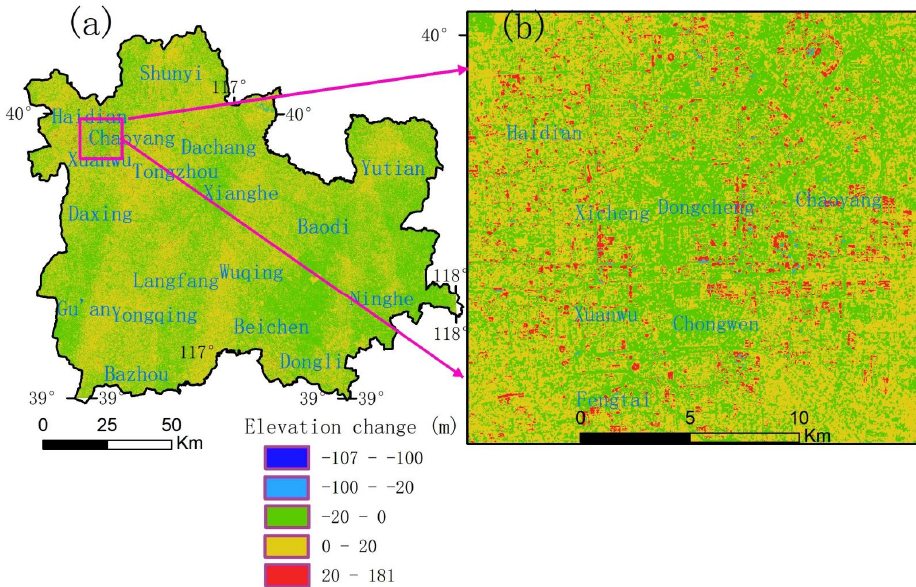
Figure 4. ( a ) Elevation change (m) obtained from the DSMs in the study area; ( b ) Enlarged view of elevation change in central urban area of Beijing.